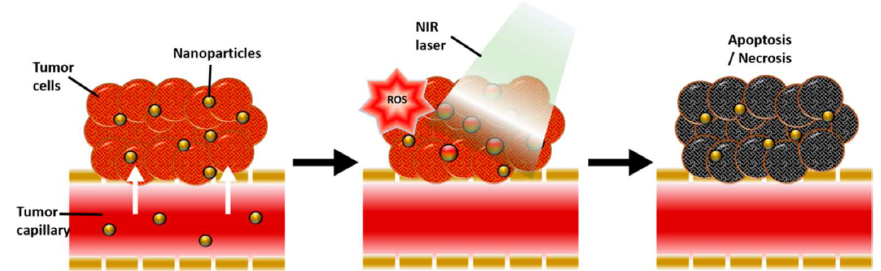
Figure 8. Schematic illustration of the physiological and biological effects of gold nanoparticle mediated photothermal therapy (PTT) and photodynamic therapy (PDT) [45]. Reprinted from Ref. [45].